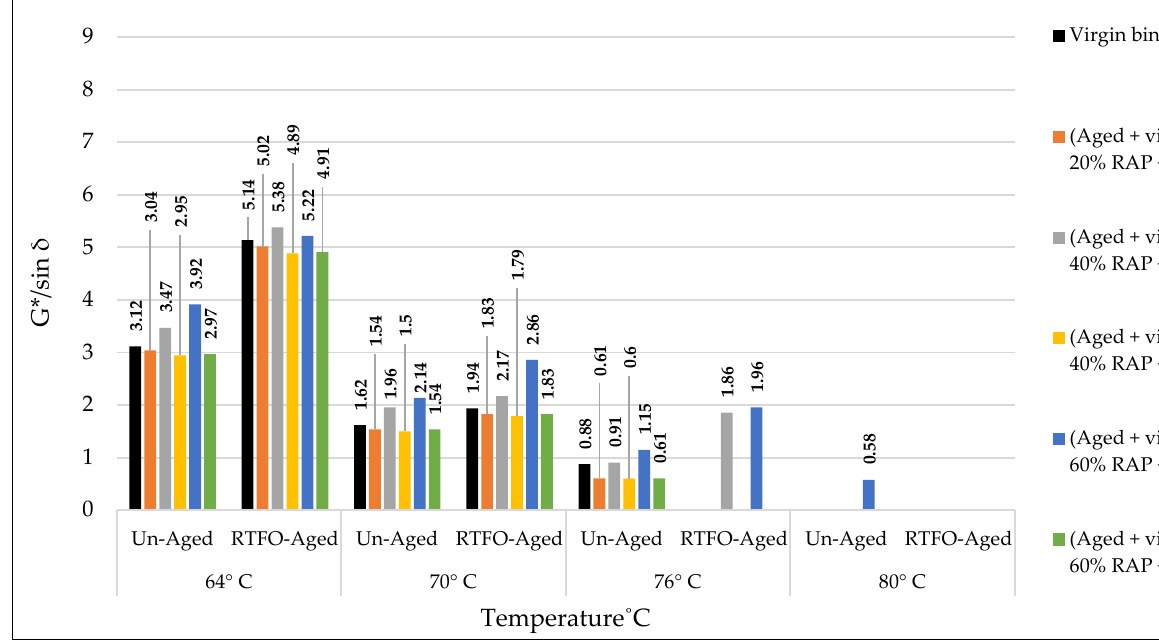
Figure 21. Rutting index (G*/sin δ ) for the aged blends of binders rejuvenated by WCO. 2. Using WEO within the aged blend of binders has proven to be very reliable in stabi- lizing the rutting index (G*/sin δ ) equally with the control virgin binder, as shown in Figure 22. Best results were achieved by the rejuvenated blends of 20% RAP + 10% WEO, 40% RAP + 12.5% WEO, 40% RAP + 17.5% WEO, and 60% RAP + 17.5% WEO, whereas levels of G*/sin δ for the noted blends of binders are higher or similar to the level of virgin binder, which indicates high resistance to rutting deformation. Through the modification of the old binder components and restoration of the lost physical and chemical properties, the distinctive WEO structure works to improve the aged binder’s molecular structures and provide cohesive bonding. Woszuk et al. [55] support these outcomes using the same testing procedure at only two degrees of test temperatures.